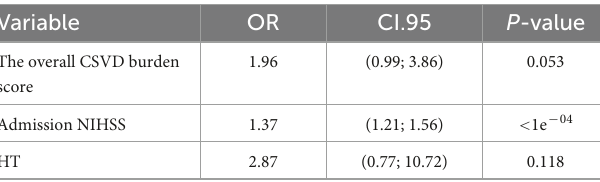
TABLE 3 The clinical model of multivariate regression